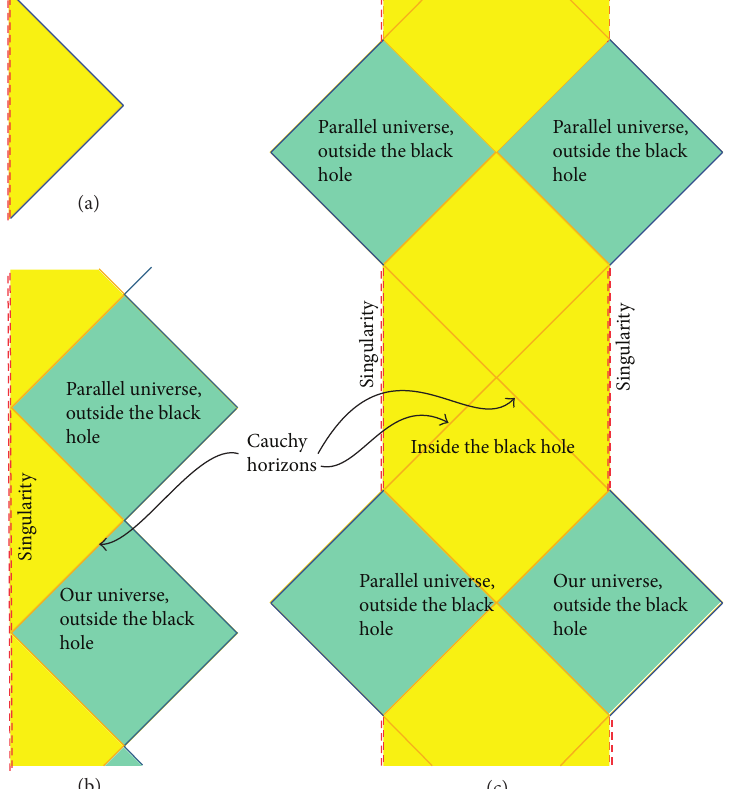
Figure 2: Reissner-Nordstr¨om black holes. (a) Naked solutions ( 𝑞 2 > 𝑚 2 ). (b) Extremal solution ( 𝑞 2 = 𝑚 2 ). (c) Solutions with 𝑞 2 < 𝑚 2 .